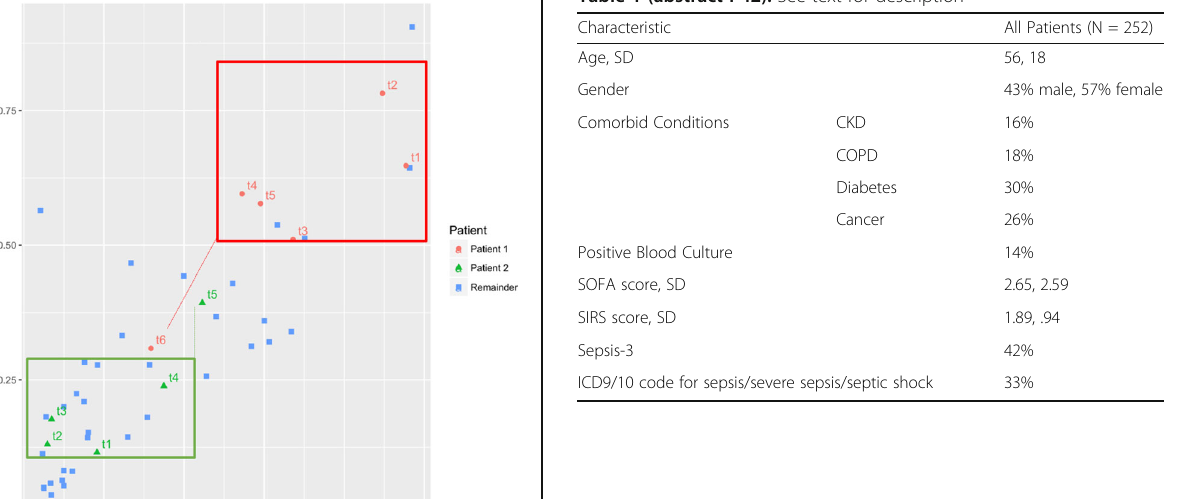
Table 1 (abstract P42). See text for description